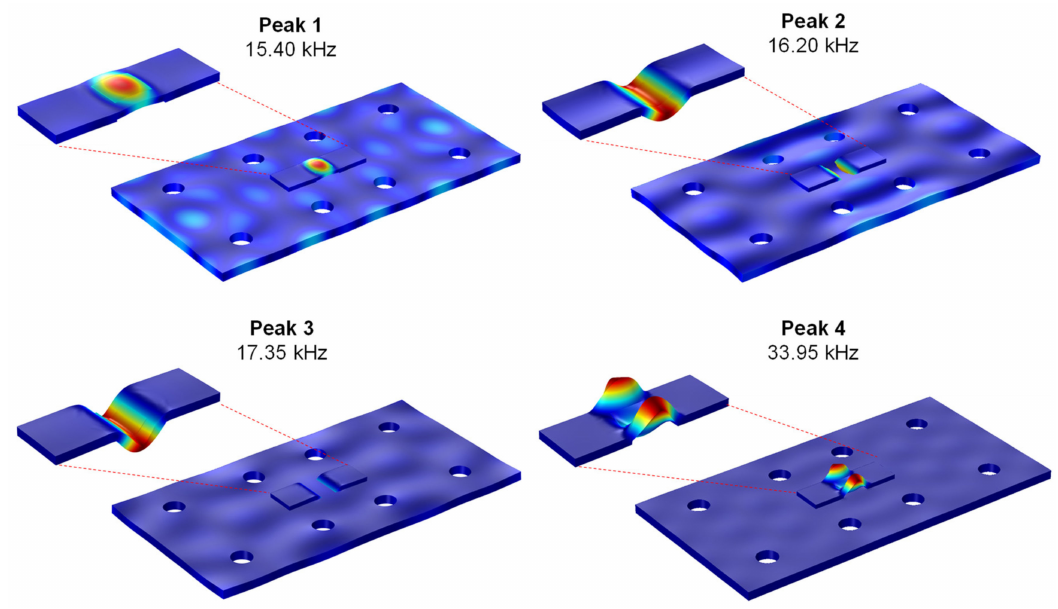
Figure 18. Coupled vibration modes between PZT interface and connection splice